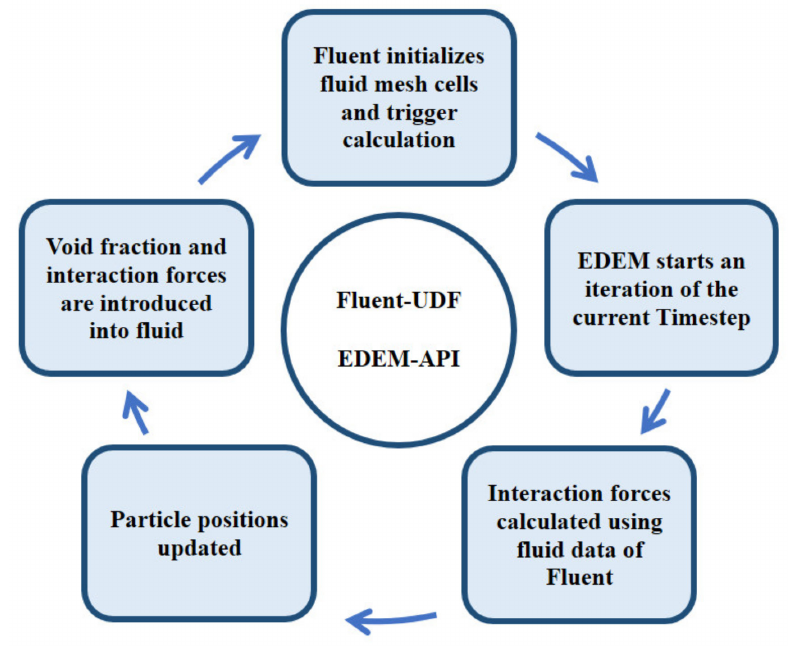
Figure 1. Fluent–EDEM coupling